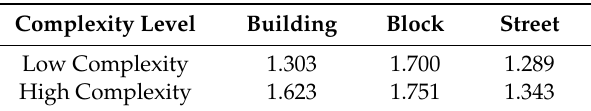
Table 1. Mean FD clustering values.